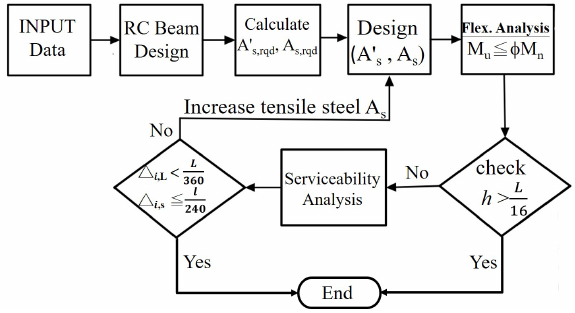
Fig. 5. Nonlinear programming-based flexural design of RC